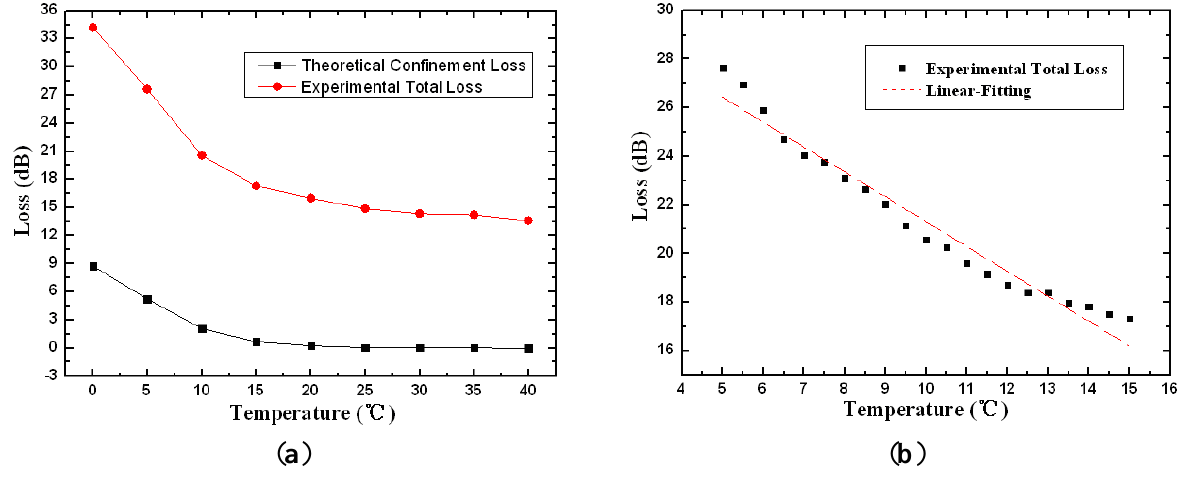
Figure 5. Theoretical and experimental loss ( a ) and linear fitting curves of the experimental loss ( b ) as functions of temperature with the volume ratio of chloroform and ethanol as